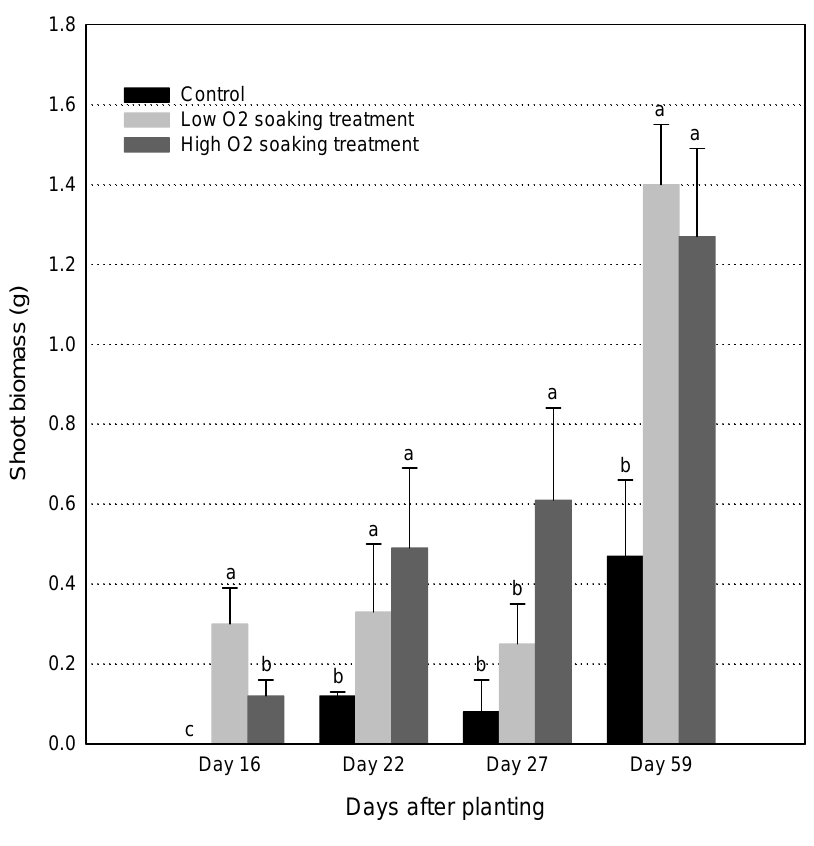
FIGURE 3 . Mean shoot biomass (g, ± s.e.) of black willow ( S. nigra ) cuttings in control, low O 2 and high O 2 soaking treatment groups for combined subsampling data on days 16, 22, 27, and